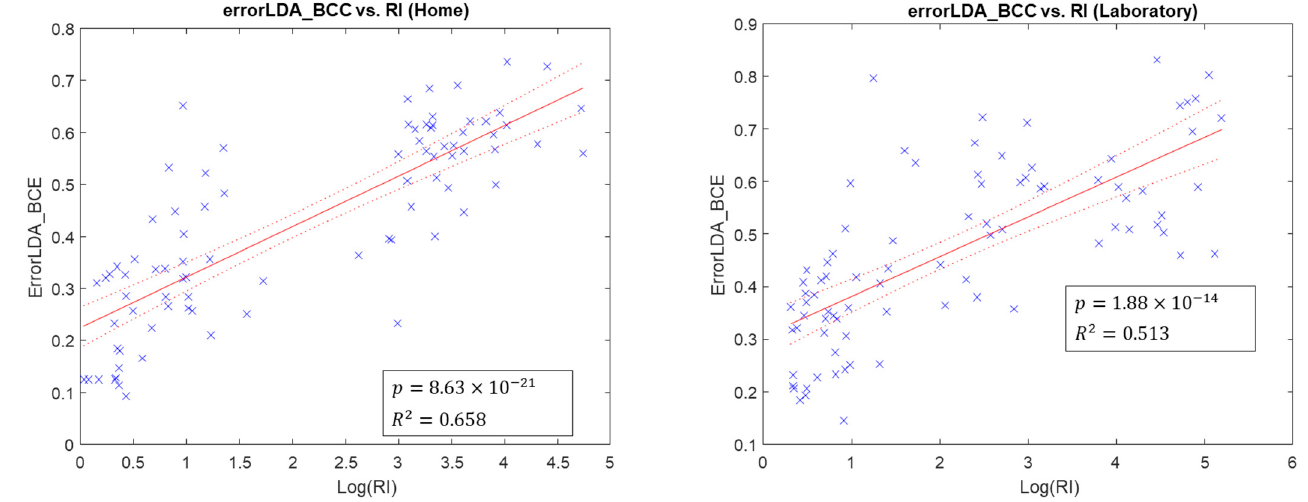
Figure 4. Scatter plots of linear regression fitted models (in red), where BCC error is related to RI. Each blue x represents a sample result.